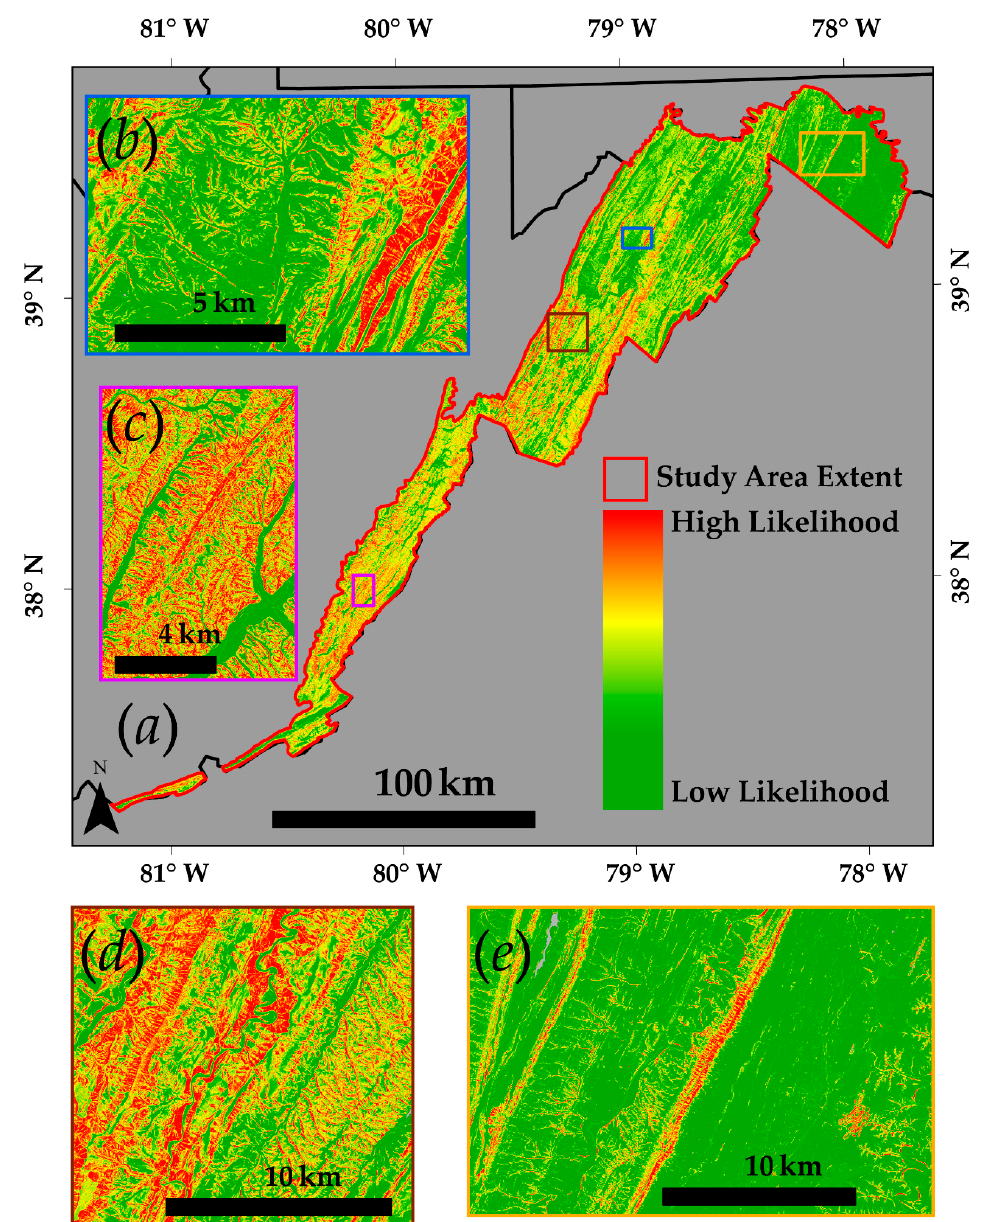
Figure 5. Resulting slope failure likelihood model created using the five combined models for ( a ) the entire mapped extent and ( b – e ) more detailed examples at larger